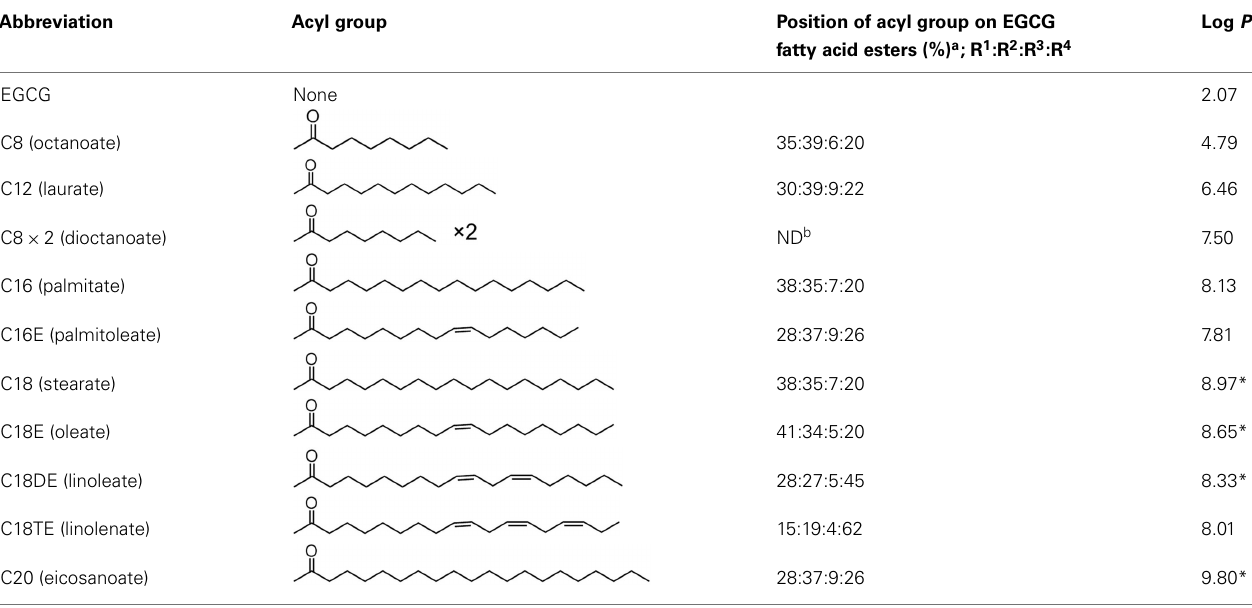
Table 1 | EGCG fatty acid esters and the ratio of their